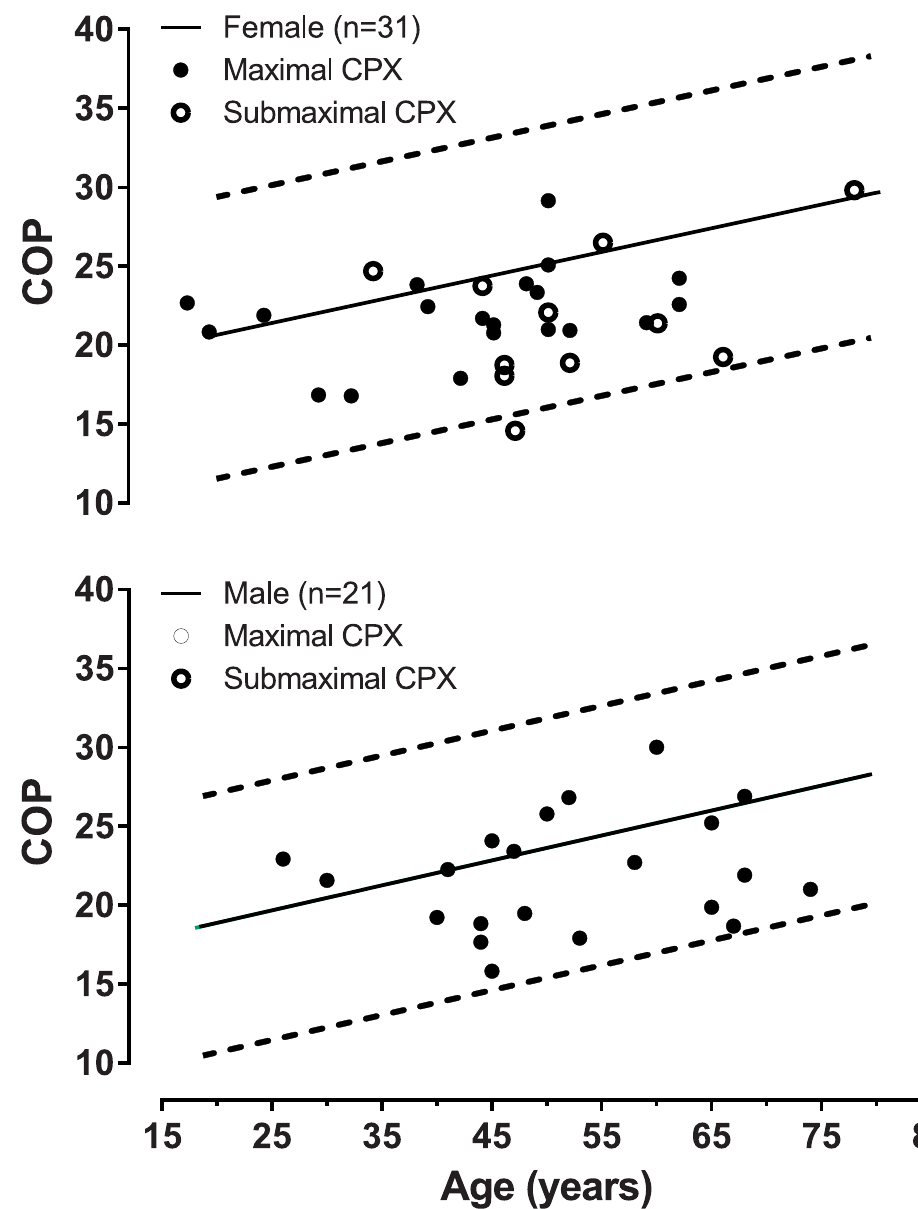
Figure 2. COP results for PD patients and maximal and submaximal CPET compared with the age and gender-predicted values.